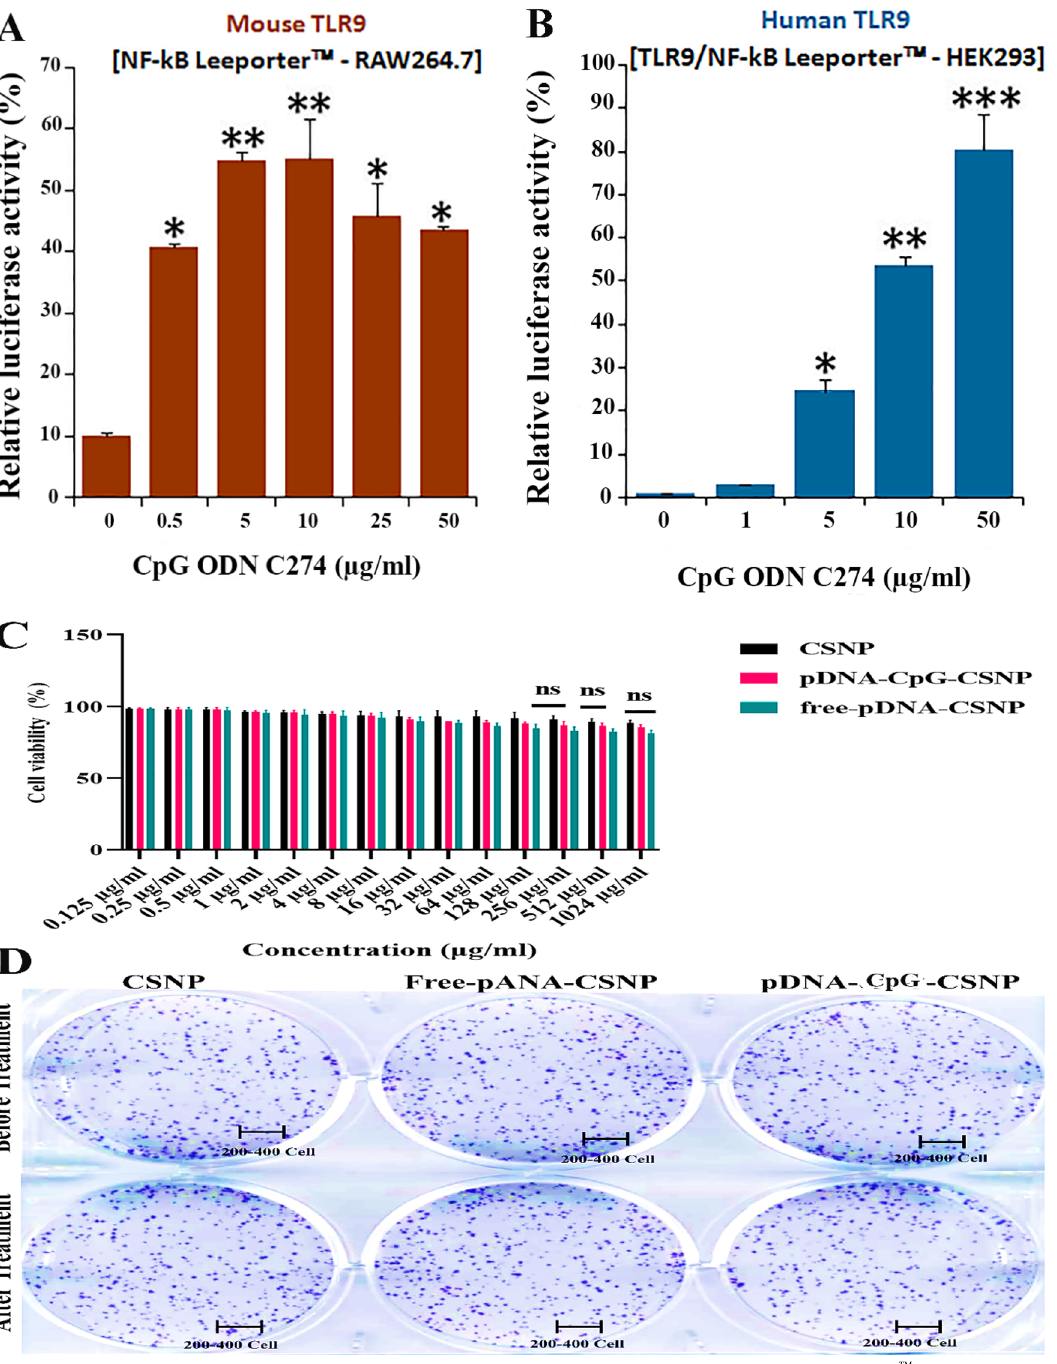
Fig. 3 TLR-9 activation in human and mouse cells. A CpG ODN C274‑mediated mouse TLR-9 activation in NF‑kB Leeporter ™ —RAW 264.7 cells. B CpG ODN C274‑mediated human TLR-9 activation in TLR-9 /NF‑kB Leeporter ™ —HEK293 cells. *p of different formulations of nanovaccines after 24 h on RAW/HeK‑293 cells. D Cell colonies of RAW/HeK‑293 trated with CSNP, Free‑pDNA‑CSNP and pDNA‑CpG‑CSNP were stained with Giemsa. Experiments were performed in